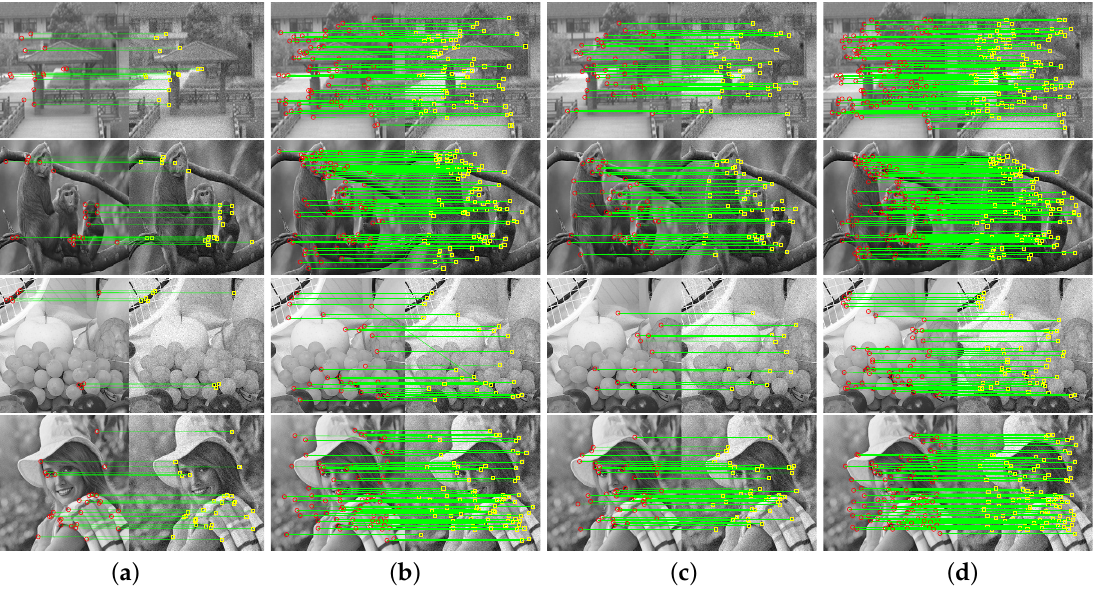
Figure 6. Matching results of noised images: ( a ) Harris results; ( b ) SIFT results; ( c ) PCA-SIFT results; ( d ) our results.